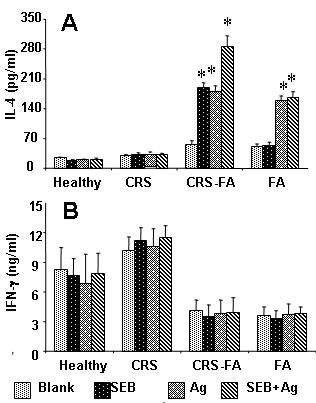
Peripheral blood mononuclear cells (PBMCs) were got from all subjects and cultured in the presence of specific antigens. Supernatants were collected on day 4 and subjected to the assessment of IL-4 (A) and IFN-γ (B) with ELISA. Blank: no special treatment. Ag: treated with specific antigens. SEB: treated with SEB; SEB+Ag: treated with the combination of SEB and Ag. Data are presented as mean ± SD. *, p < 0.05, compared with blank group; #, p < 0.05, compared with the groups treated with Ag alone or with SEB alone.